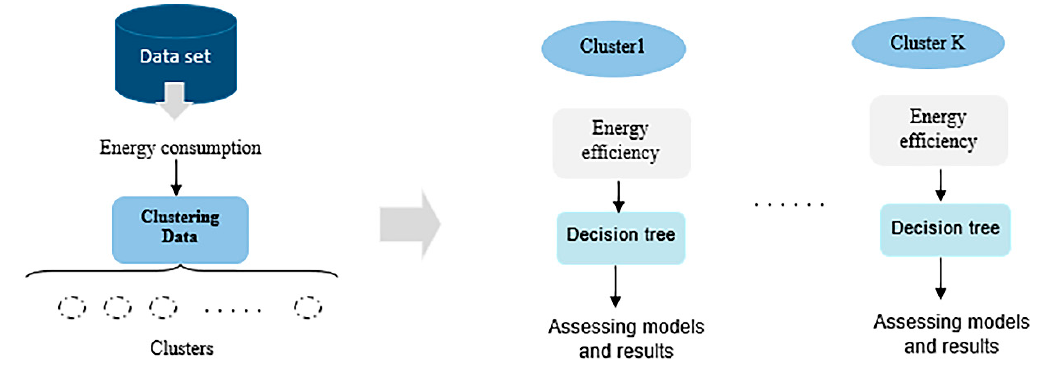
Figure 2. An overview of the proposed approach.